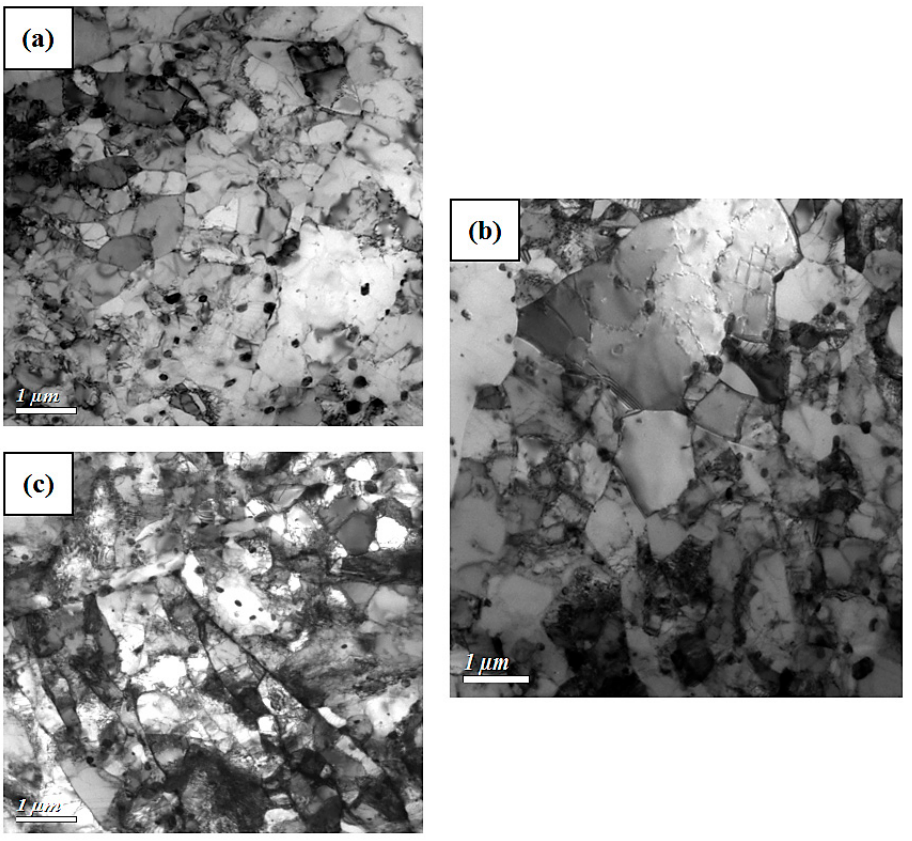
Figure 6. TEM micrographs of the ( a ) 1060NT-OT, ( b ) 940NT-OT and ( c ) 1060NT-PT samples.